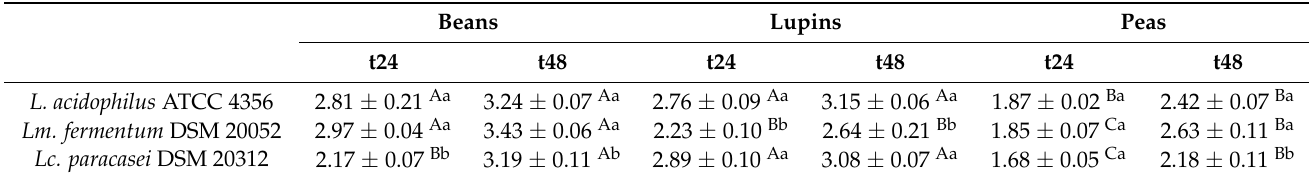
Table 4. Differences in cell densities, reported as ∆ log cfu mL − 1 after 24 and 48 h of incubation at 37 ◦ C, of legume grain water extracts inoculated with selected LAB